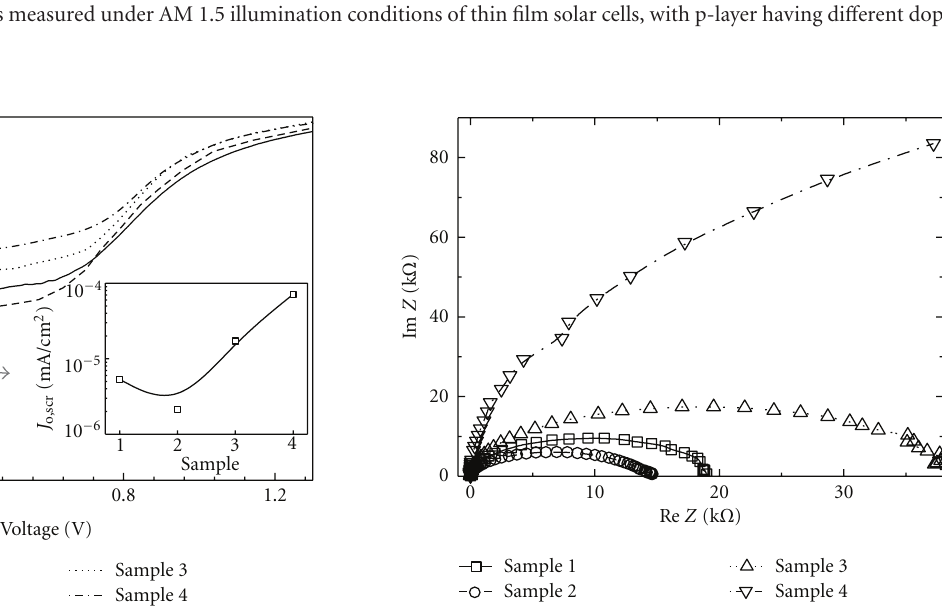
Figure 6: Cole-Cole plot of a-Si solar cell having di ff erent p-type layers, under zero DC